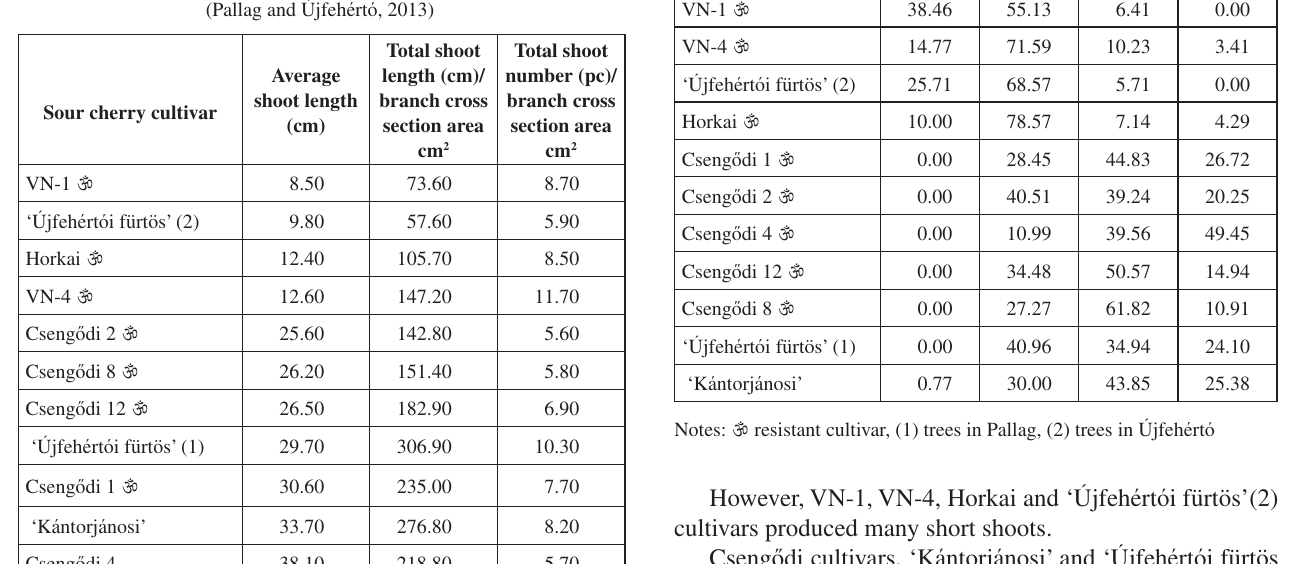
Table 2: Specific vegetative indicators of sour cherry cultivars (Pallag and Újfehértó, 2013)